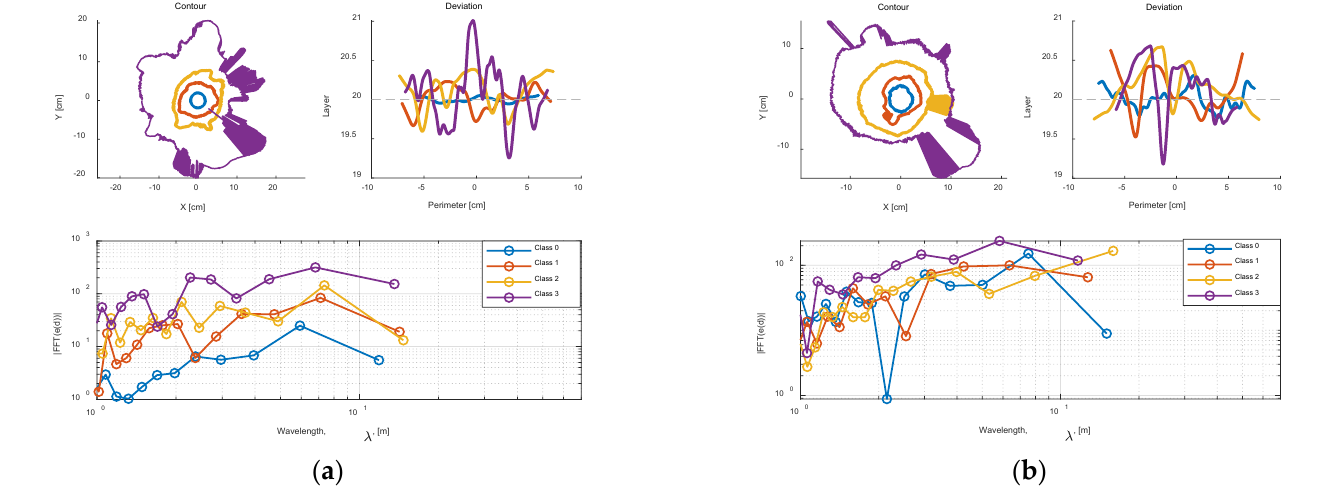
Figure 13. ( a ) Comparing the contours, deviations, and frequency response at layer 20 across the Class 0 – 3 instant trim samples; ( b ) comparing the contours, deviations, and frequency response at layer 20 across the Class 0 – 3 instant whole samples.